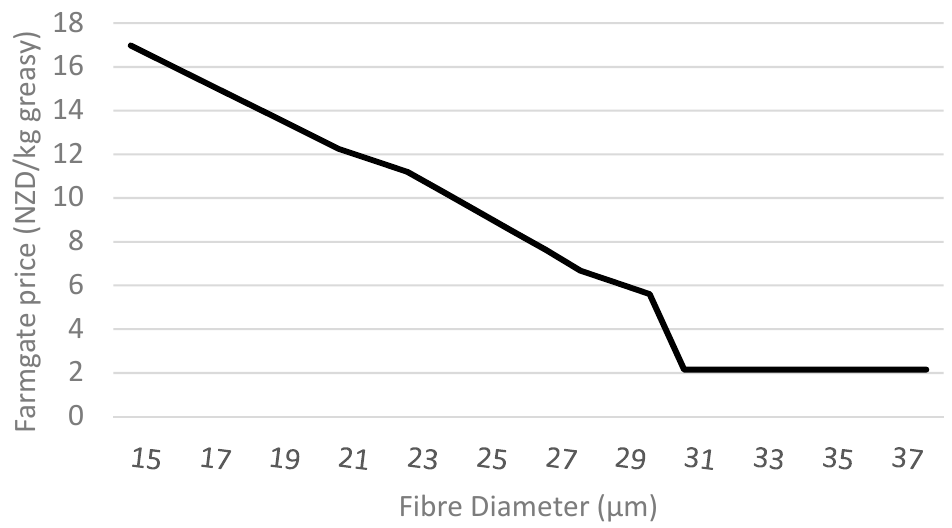
Figure 2. Farmgate wool prices in 2017/18 for various fibre diameters used in this analysis. Reprinted with permission from ref. [5]. 2021 Elsevier.